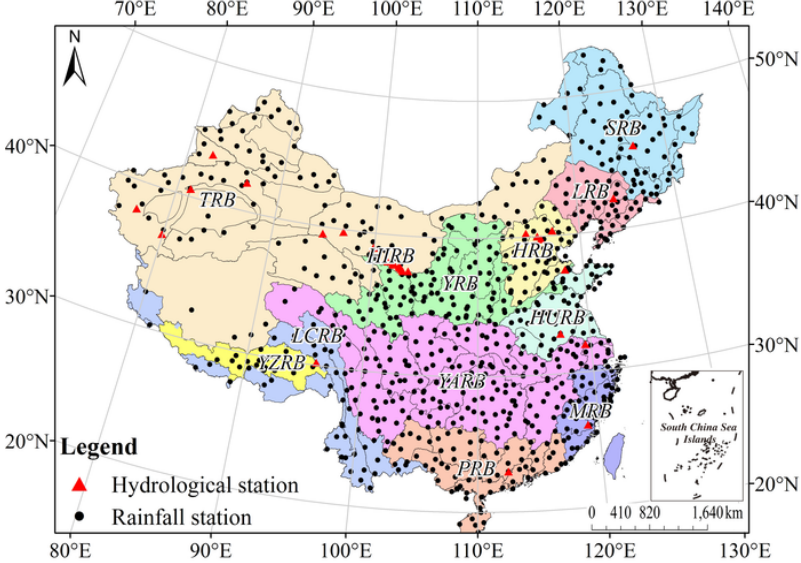
Figure 1. Distribution of 12 major basins in China showing gauge stations (red triangles) and meteorological stations (black dots) used in this